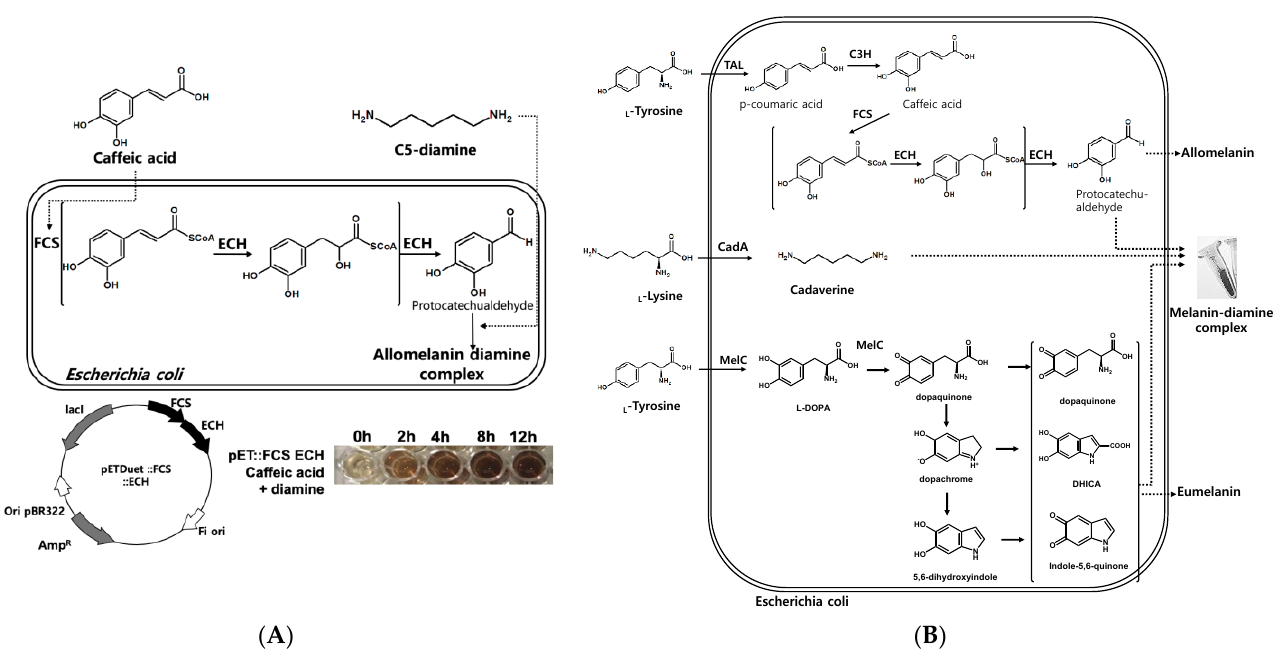
Figure 3. ( A ) Biosynthesis of the allomelanine-C5 diamine complex using E. coli cells expressing FCS and ECH enzymes, and production of the allomelanin-diamine complex from 5 mM caffeic acid and diamine. ( B ) Co-production of the eumelanin-allomelanin-diamine complex by feeding L-tyrosine and L-lysine into E. coli cells expressing tyrosinase (MelC), tyrosine ammonia-lyase (TAL), C3H, FCS, ECH, and CadA simultaneously, respectively.